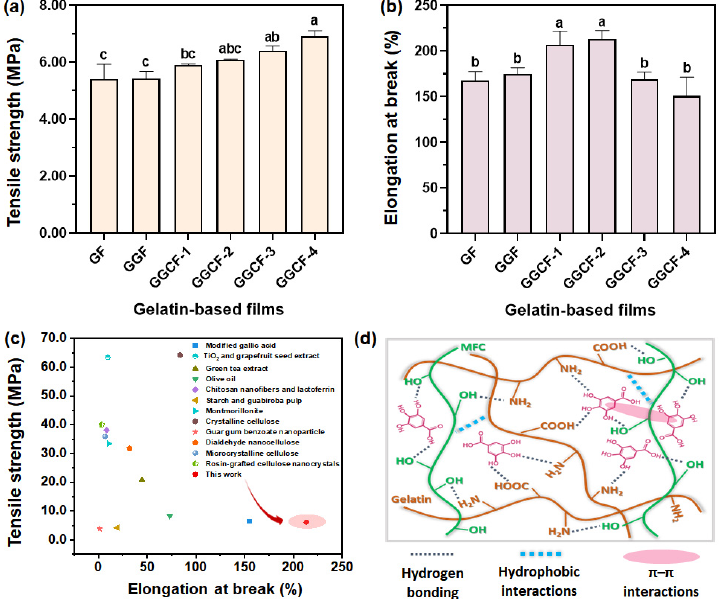
Figure 6. Tensile strength ( a ) and elongation at break ( b ) of the GBFs; ( c ) comparison of the mechanical strength of different GBFs; ( d ) the proposed reinforcing mechanism of MFC on the gelatin-based film. The results are expressed as the means ± SD (n = 3), the columns marked with different lowercase letters are significantly different from each other at p < 0.05.